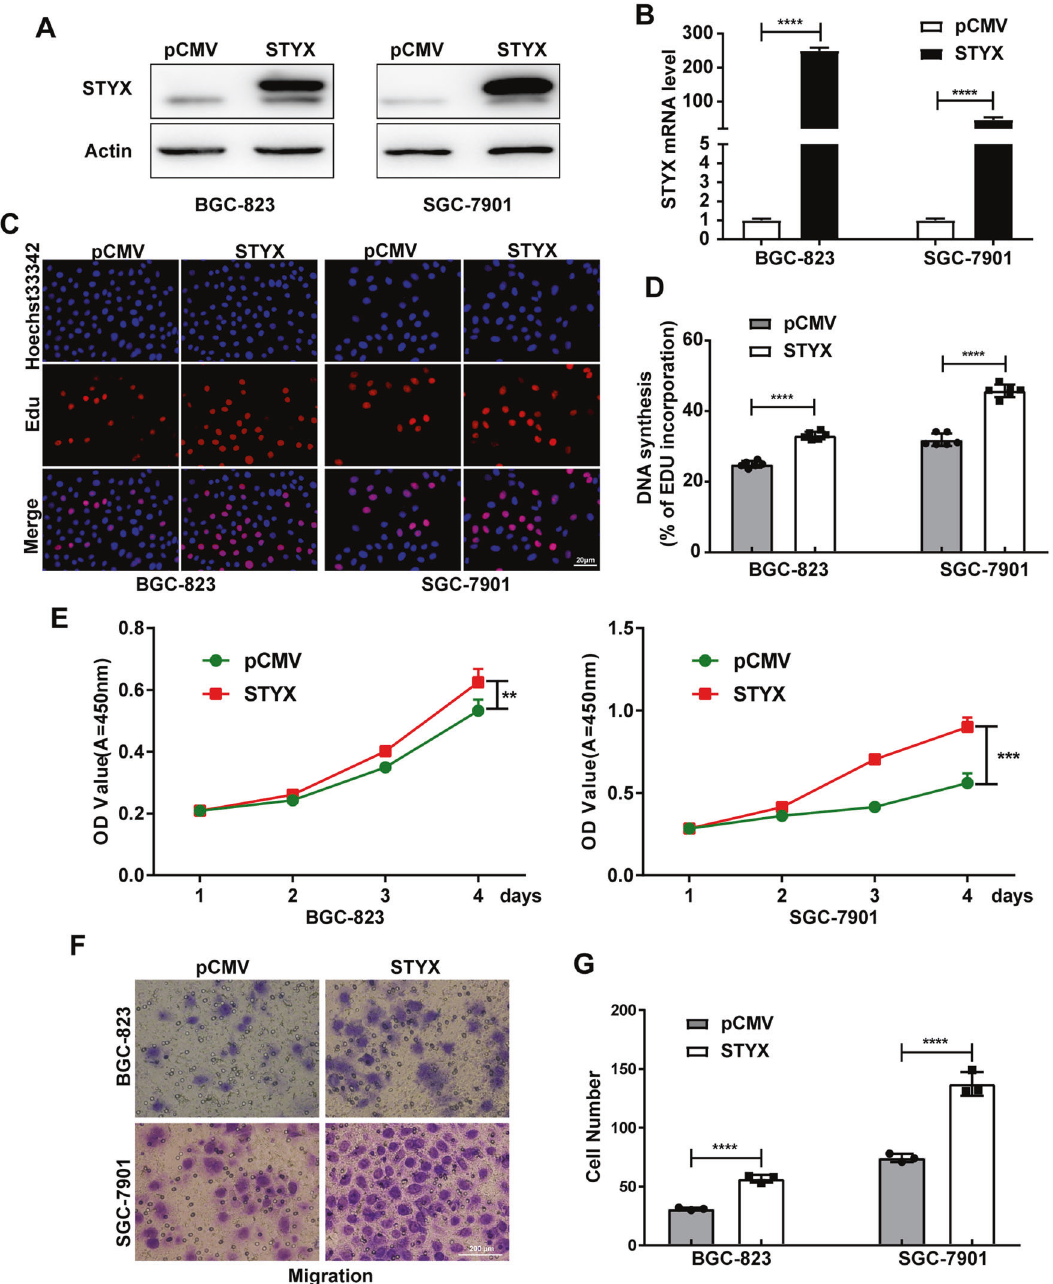
Fig. 2 STYX overexpression promotes GC cells proliferation and migration in vitro. A Western blot analysis of STYX protein level in GC cells transfected with the control vector (pCMV) or STYX overexpression vector (STYX). B qRT-PCR analysis of STYX mRNA level in transfected GC cells. C EdU analysis of the cell proliferation ability in transfected GC cells. The representative results were showed. D Statistical analysis of the EdU-positive cell ratio in GC cells. The data are expressed as the means ± SD from six independent experiments. E CCK-8 analysis of the cell proliferation ability in transfected GC cells. The data are expressed as the means ± SD from three independent experiments. F Transwell migration assay in transfected GC cells. The representative results were showed. G Statistical analysis of the cell numbers passing through the transwell fi lter in GC cells. The data are expressed as the means ± SD from three independent experiments. The data shown in D and G were analyzed using GraphPad Prism v7.0 4 software with a nonpaired Student t -test. The data shown in E were analyzed using a two-way ANOVA test. ** p < 0.01; *** p < 0.001; **** p <